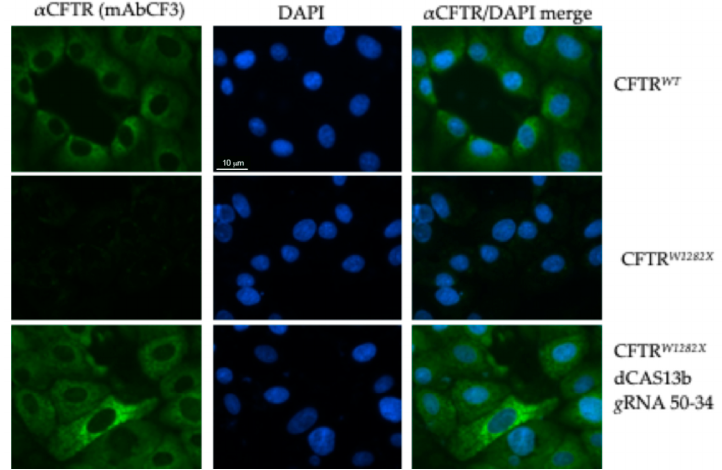
Figure 6. Immunofluorescence detection of CFTR protein in FRT-CFTR W1282X cells. Cells Immunofluorescence detection of CFTR protein in FRT-CFTR W1282X cells. untransfected (negative control) and transfected with the plasmids encoding the indicated g RNA and Cas13b/ADAR2 DD (300 ng total DNA) are shown. FRT-CFTR WT cells were used as a positive control. Cells were fixed with methanol and the CFTR protein was revealed by the primary antibody mAbCF3, followed by a secondary antibody anti-mouse Alexa-488, (green, Abcam). Nuclei (blue) were DAPI stained. Images were taken at 100x magnification on a ZEISS microscope equipped for epifluorescence.